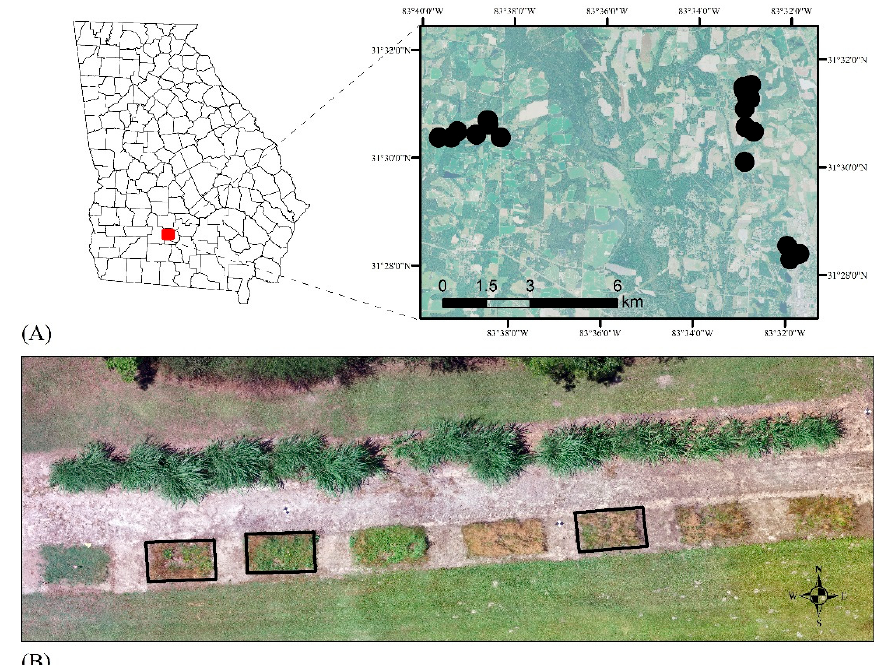
Figure 1. Location map. The distribution of buffer plots across the experimental farm stations of University of Georgia near Tifton, Georgia ( A ), and one of the experimental plots showing three subplots (outlined in black) sown with wildflower mixes ( B ).